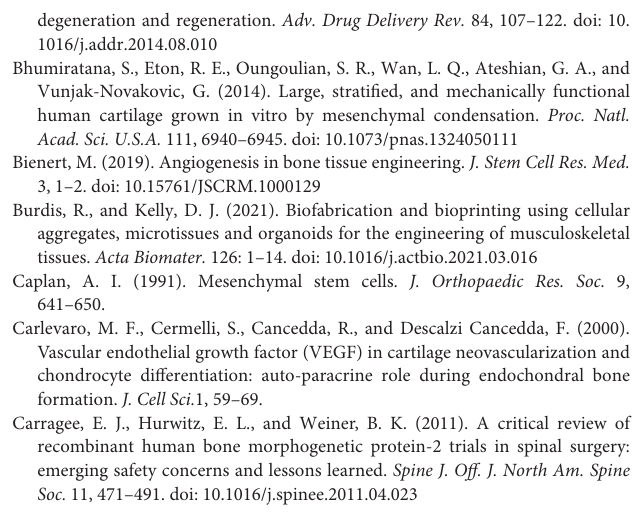
femur. Ii and iii rat femoral bone segment stl file. iv and v 3D representation of printing design. (B) macroscopic image of scaffold prior to implantation